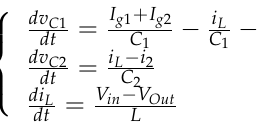
Figure 7. Equivalent simulation model. The state equation of mode 1 can be obtained from Figure 7a.